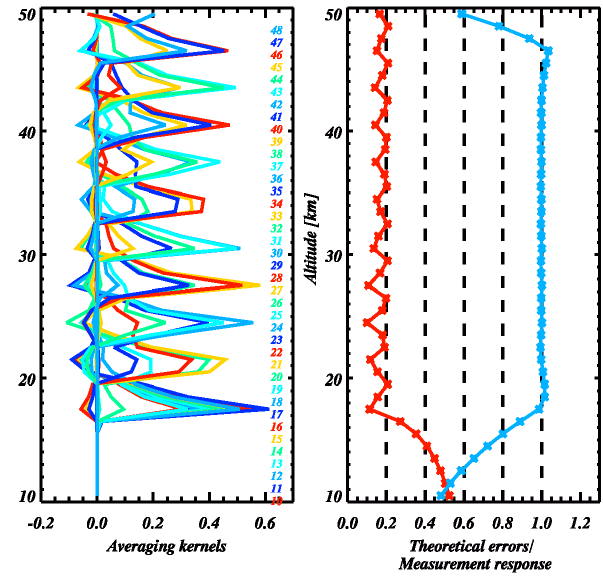
Fig. 11. The left panel shows the averaging kernels and the right panel shows the theoretical errors (red line) and the measurement re- sponse function (blue line). The measurement is on 13 March 2006, orbit=21085, SZA=109.137 and the moon